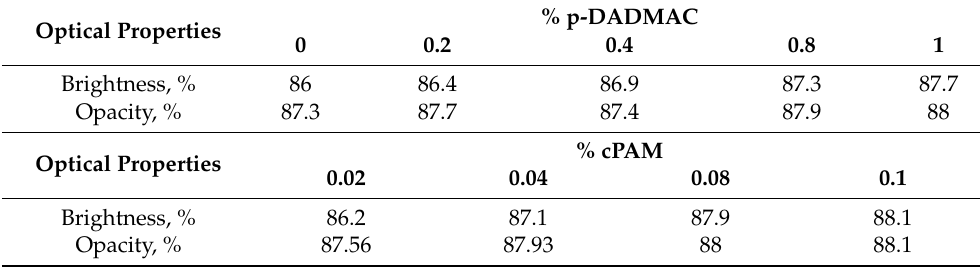
Figure 6. The influence of polyDADMAC ( a ) and cPAM ( b ) polymers on brightness and opacity properties of the paper loaded with PPC. Table 3. Optical properties for the